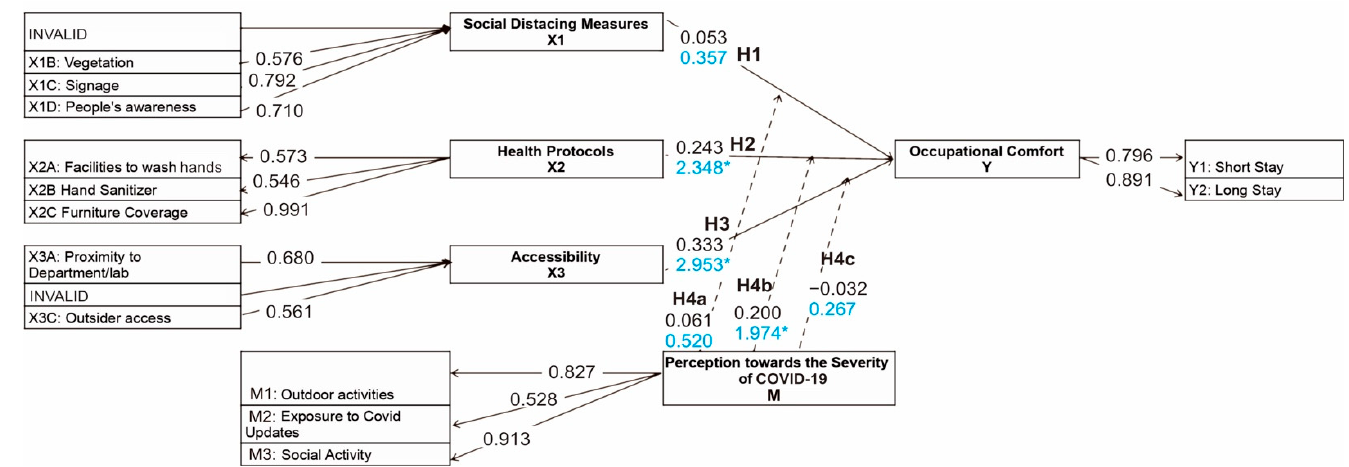
Figure 6. PLS algorithm and bootstrapping result of the proposed model. * p < 0.05.